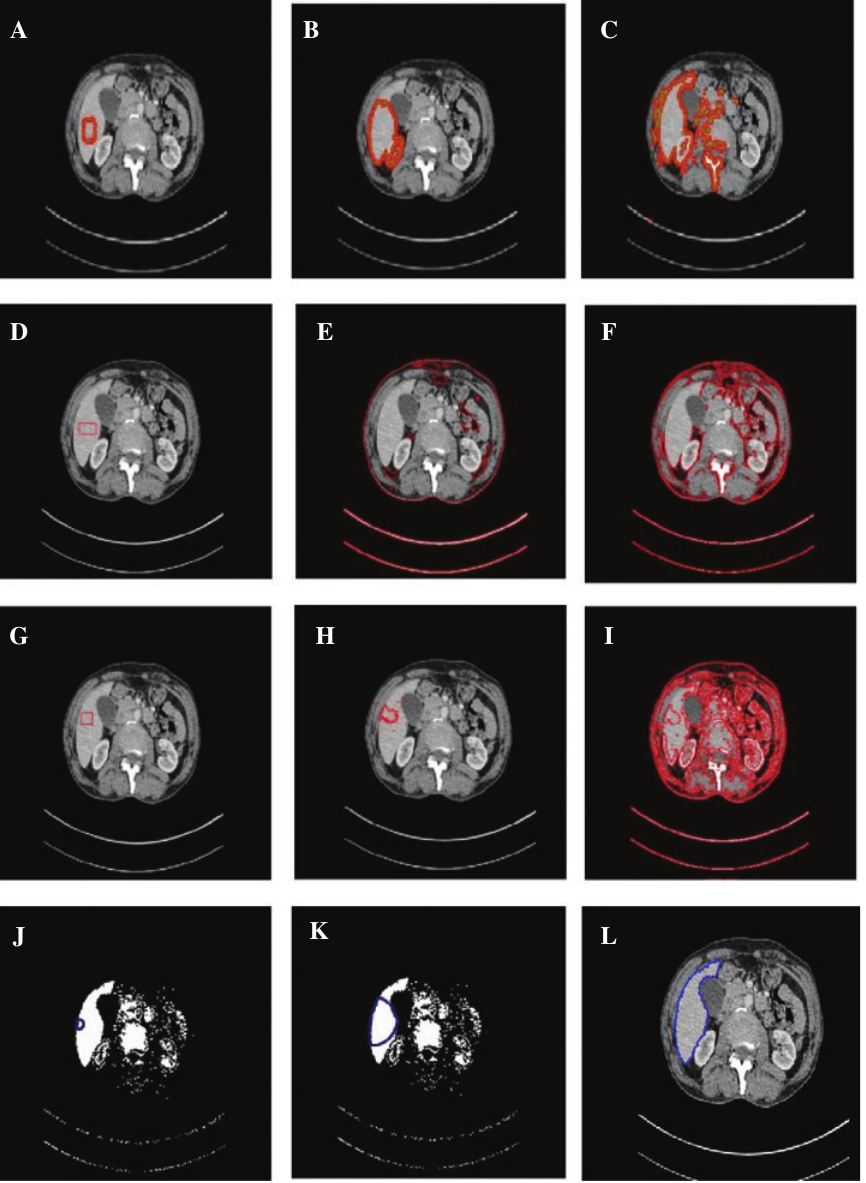
Figure 5: Liver segmentation results comparison between proposed method and existing methods. (A, D, G, and J) Initial contour in the liver image for the C-V, LSE, and RSF models and the proposed method, respectively; (B, E, H, and K) intermediate results for the C-V, LSE, and RSF models and the proposed method, respectively; and (C, F, I, and L) final segmentation results for the C-V, LSE, and RSF models and the proposed method,